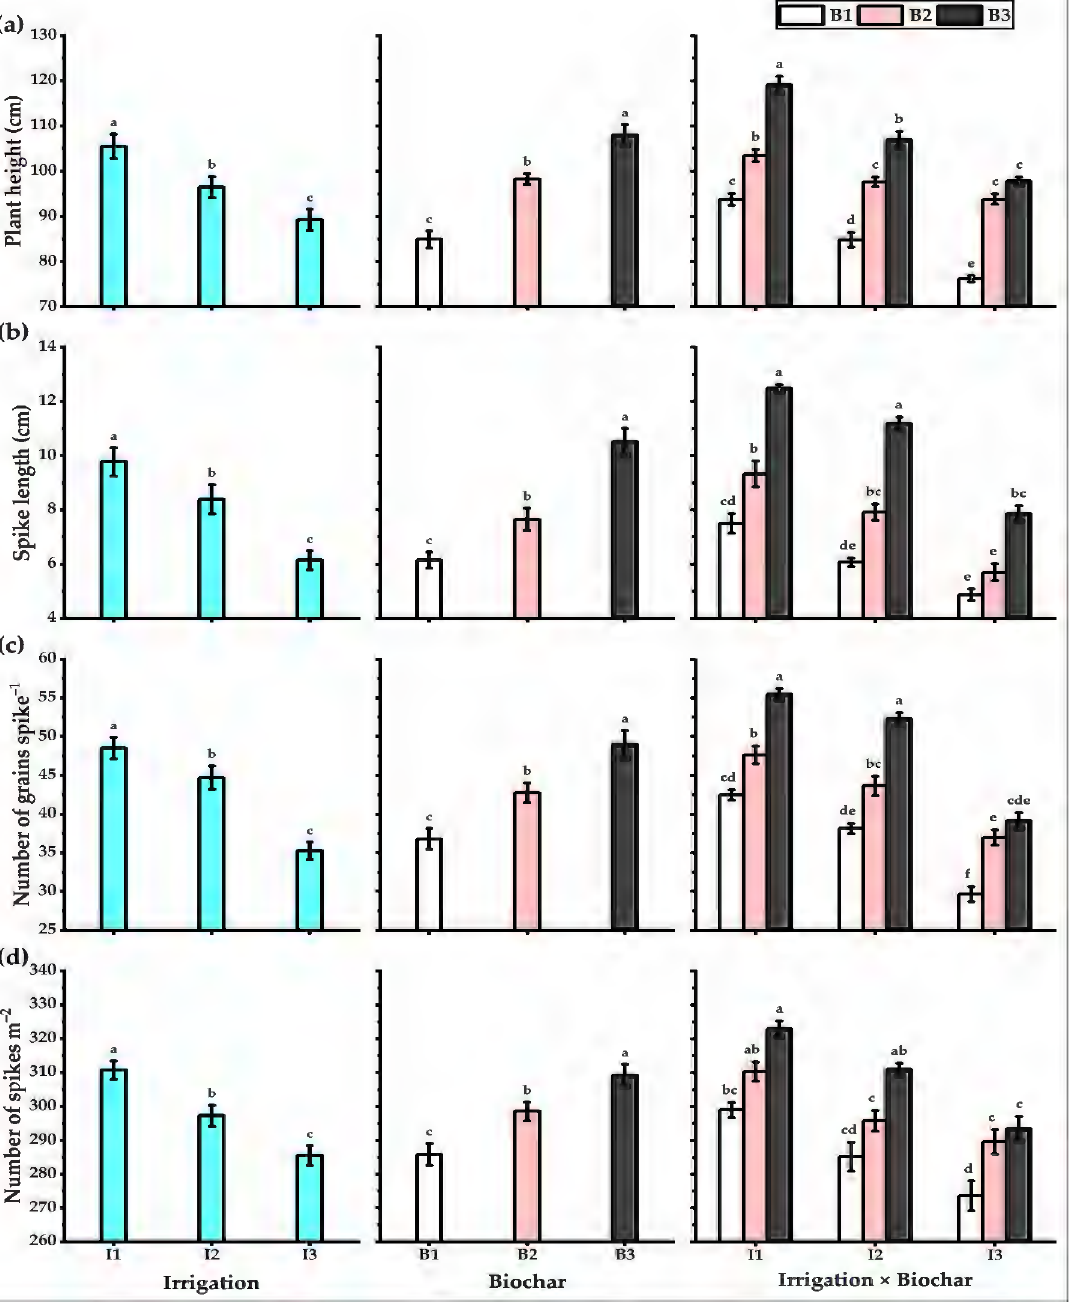
Figure 2. ( a ) Plant height (cm), ( b ) spike length (cm), ( c ) number of grains spike − 1 , and ( d ) number of spikes m − 2 of the wheat plants affected by three irrigation levels of 100 (I1), 80 (I2), and 60% (I3) of crop evapotranspiration (ETc), and three levels of biochar soil supplementation, 0 (B 1 ), 7.5 (B 2 ), and 15 t ha − 1 (B 3 ). Bars and error bars represent the means ± SE, respectively, of three biological replicates. Different letters reveal statistically significant differences among